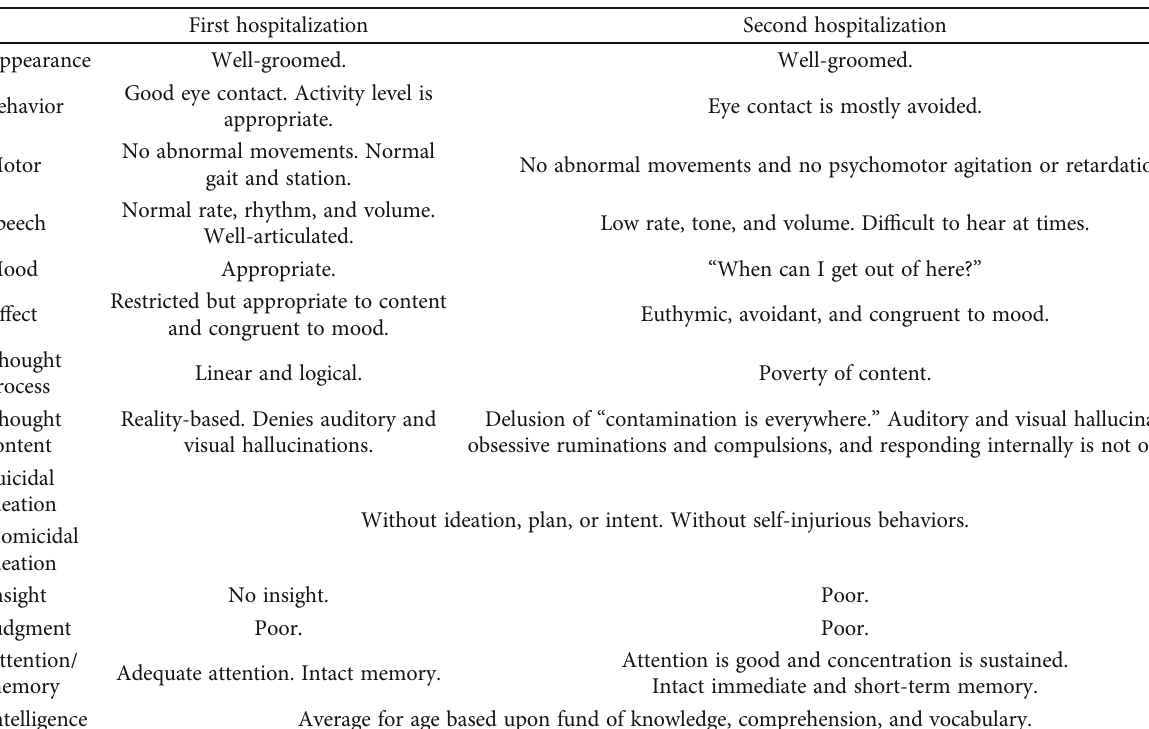
Table 1: Mental status exam on each admission for the fi rst and second hospitalizations. First